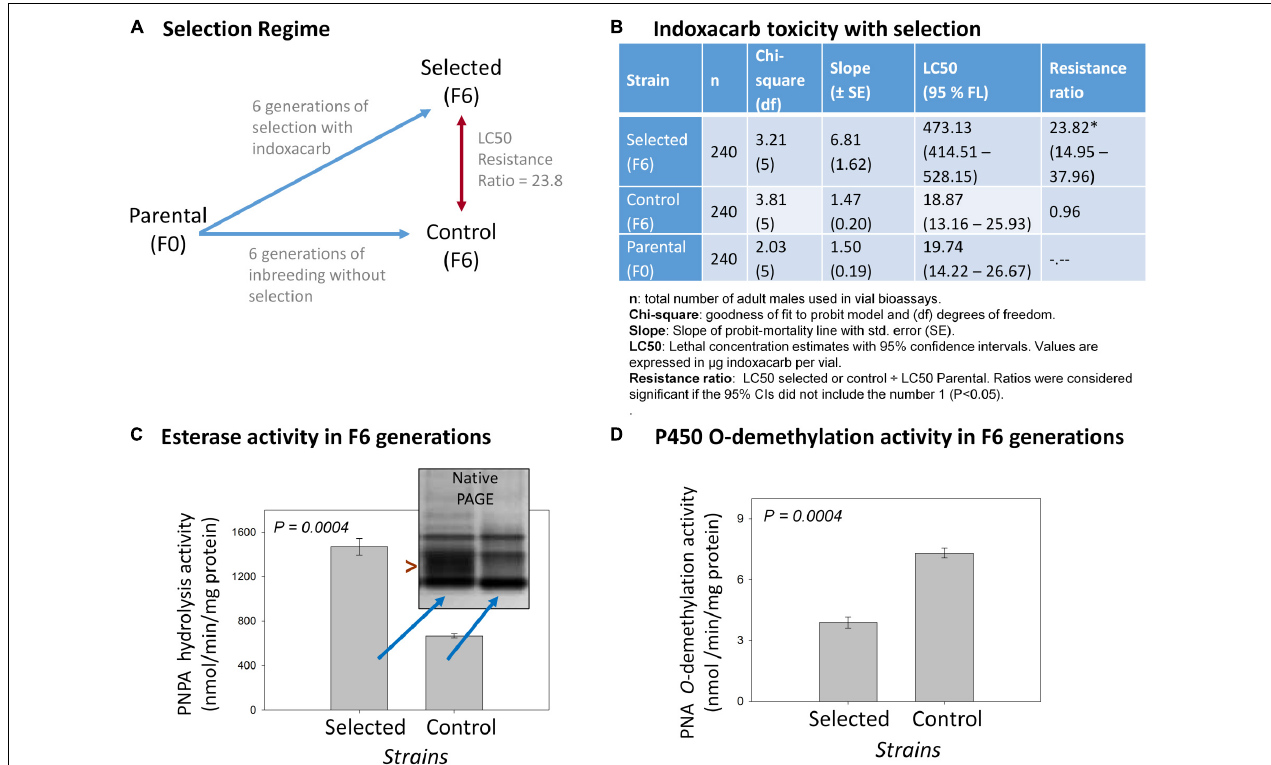
FIGURE 1 | Overview of the indoxacarb selection process and key associated findings. (A) Diagram of the selection regime over six generations resulting in a F6-selected strain having 23.3-fold indoxacarb resistance. (B) Concentration-response vial bioassay results on selected F6, control F6 and Parental F0 lines showing LC50 determination outcomes and resistance ratios. (C) Cytosolic esterase activity in the F6 selected and F6 control lines using the model substrate p -Nitrophenylacetate (PNPA) and also by native PAGE visualization (inset). (D) Microsomal cytochrome P450 O -demethylation activity in the F6 selected and F6 control lines using the model substrate p -Nitroanisole